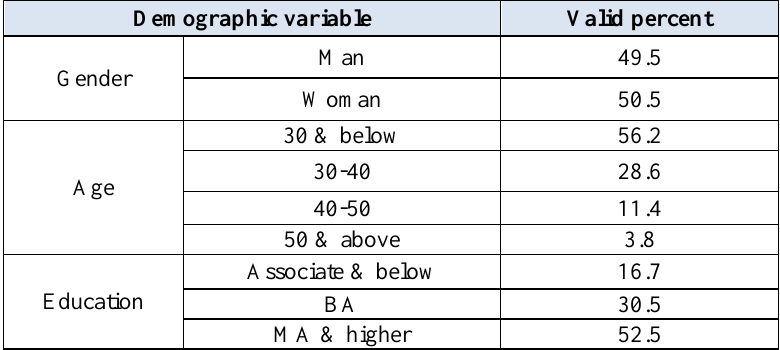
Table 4. Demographic characteristics of